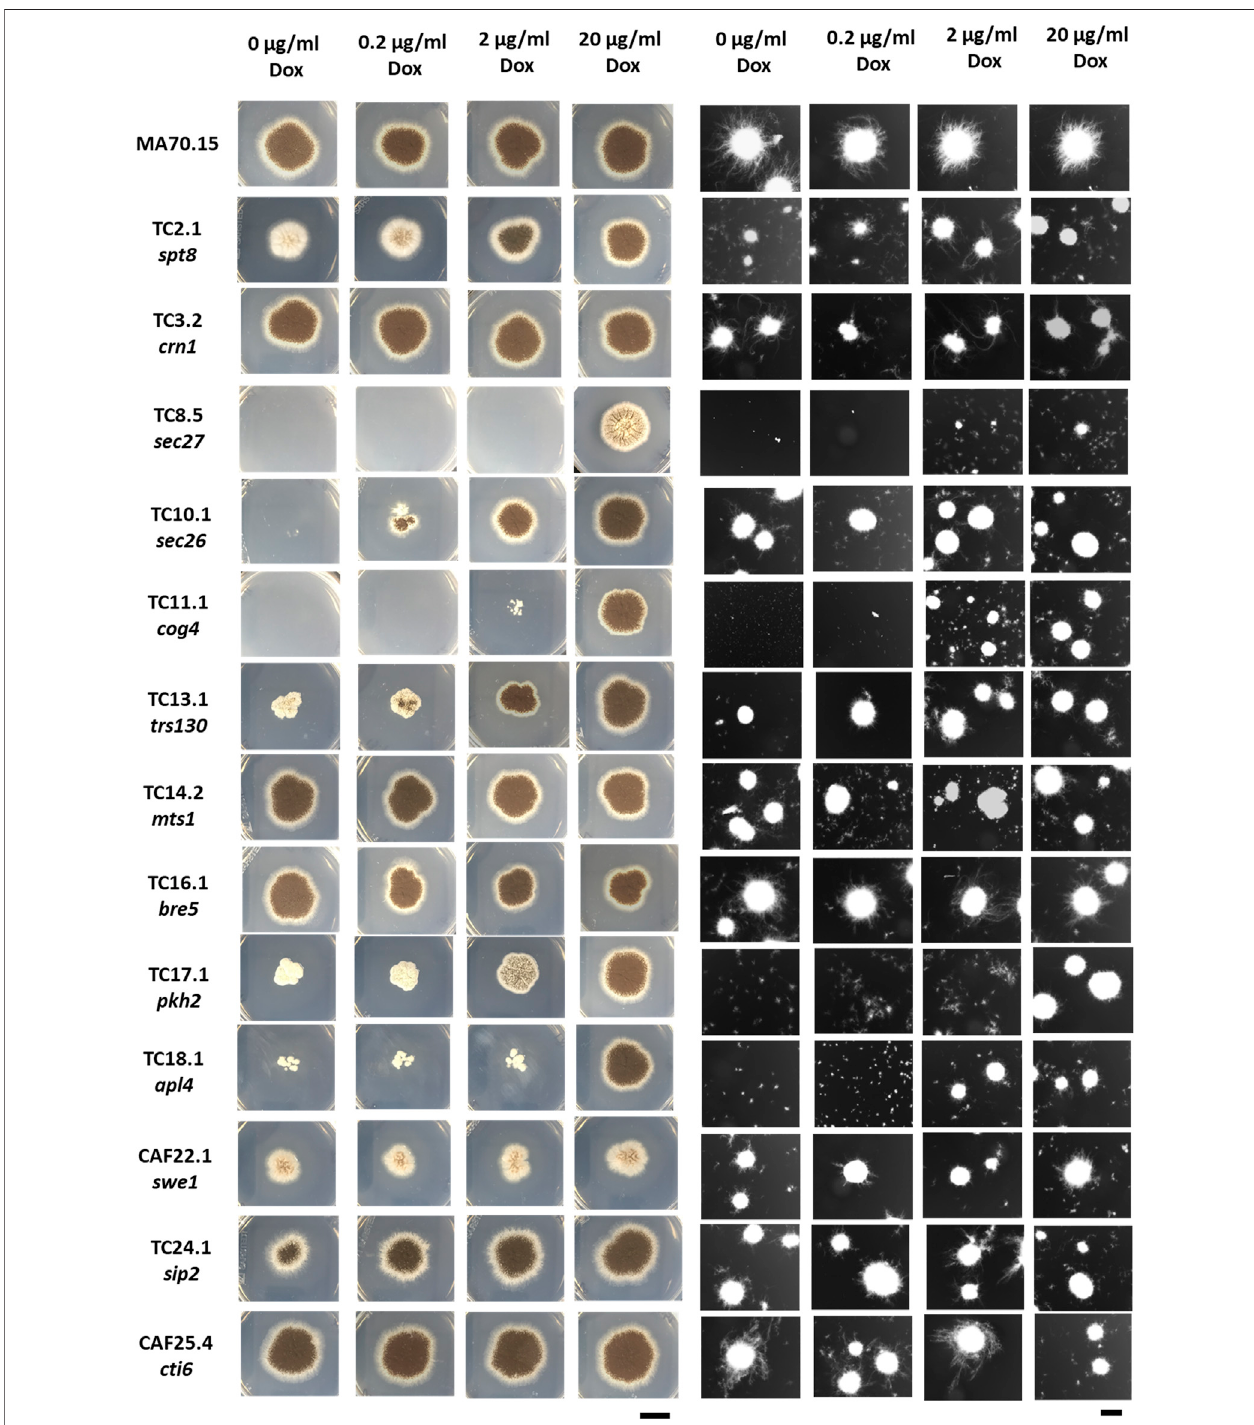
FIGURE 2 | Solid and liquid growth of the morphogene library following titration using Dox. Colony development after 5 days growth at 30 ° C on solid MM (left panels). Scale bar (cid:2) 1 cm. Representative images of submerged growth in CitACM media for 96 h at 220 RPM, 34 ° C (right panels). Scale bar (cid:2) 1 mm.